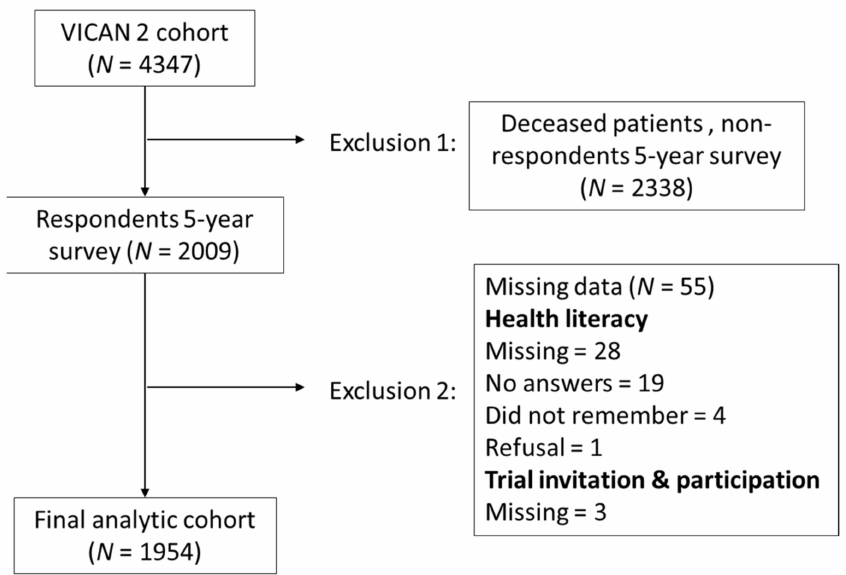
Figure 1. Flowchart of